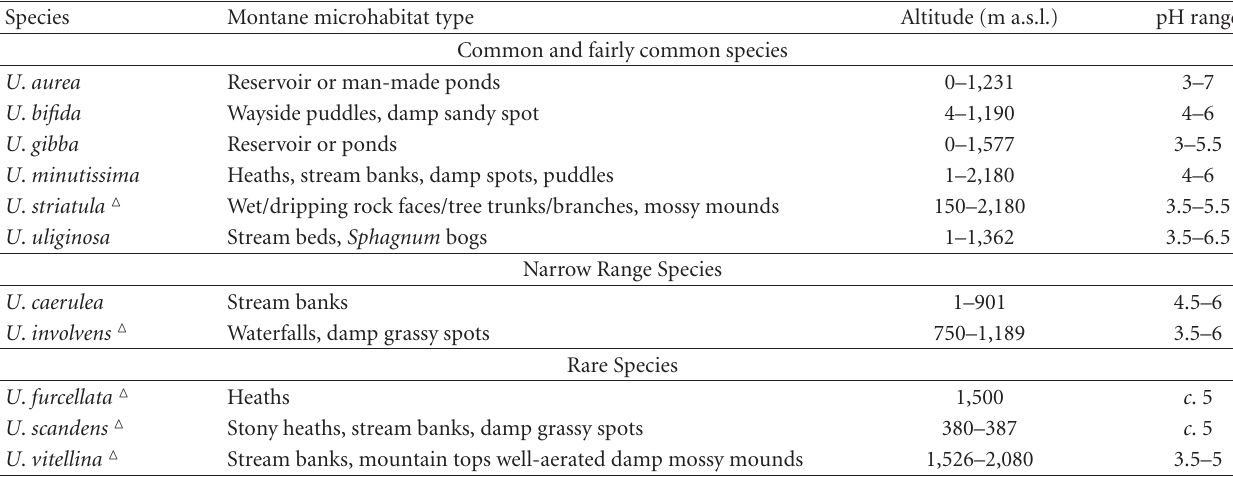
Table 4: Utricularia of Peninsular Malaysia montane microhabitat details.